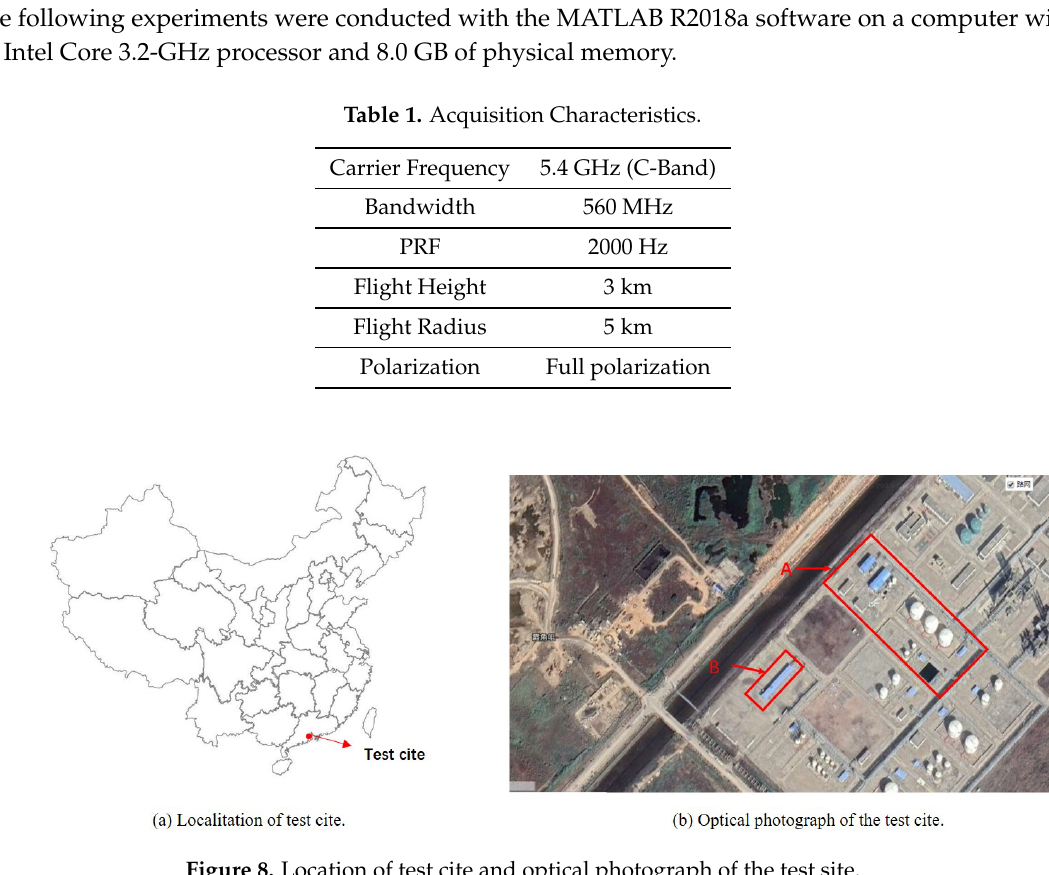
Figure 8. Location of test cite and optical photograph of the test